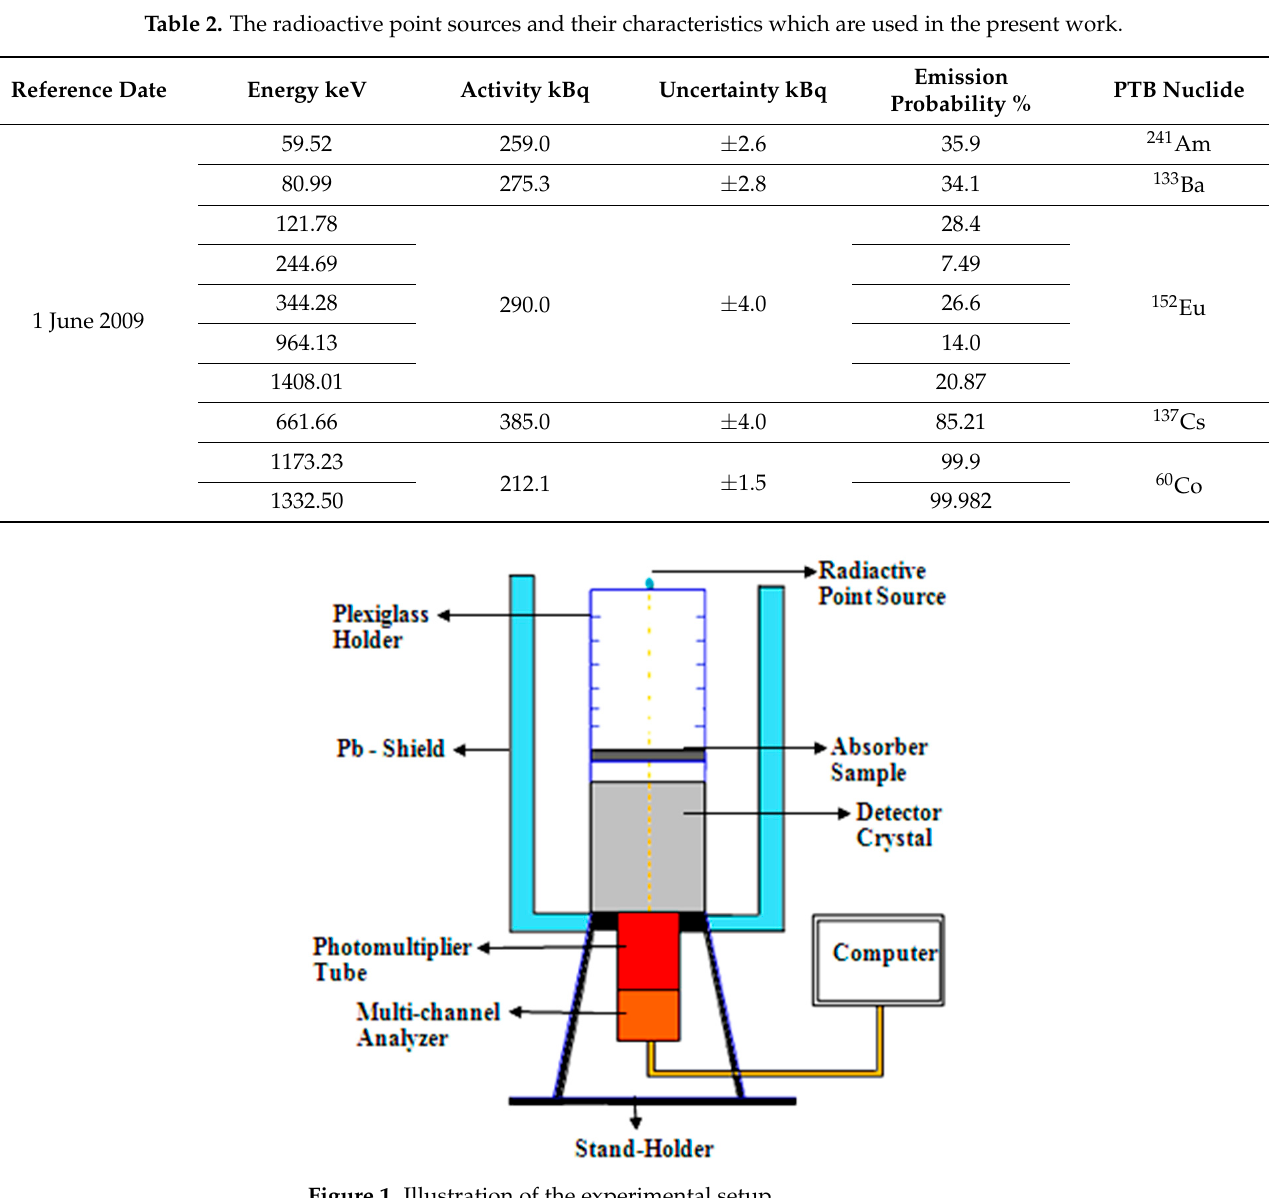
Figure 1. Illustration of the experimental